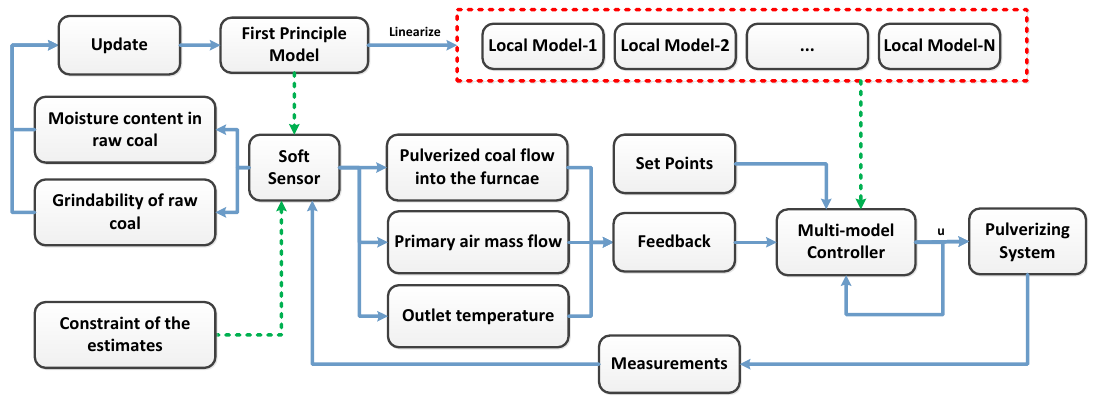
Figure 5. Inferential control system structure.